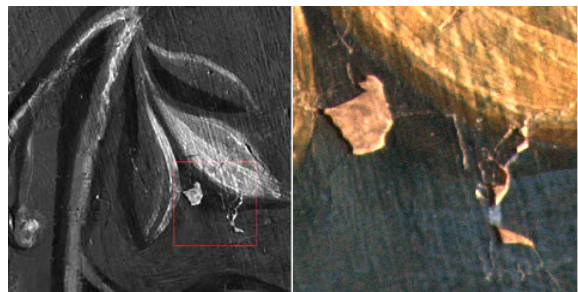
Figure 10. (left) Area from lower centre of image with red square showing the detail of 300x300 pixels (right).